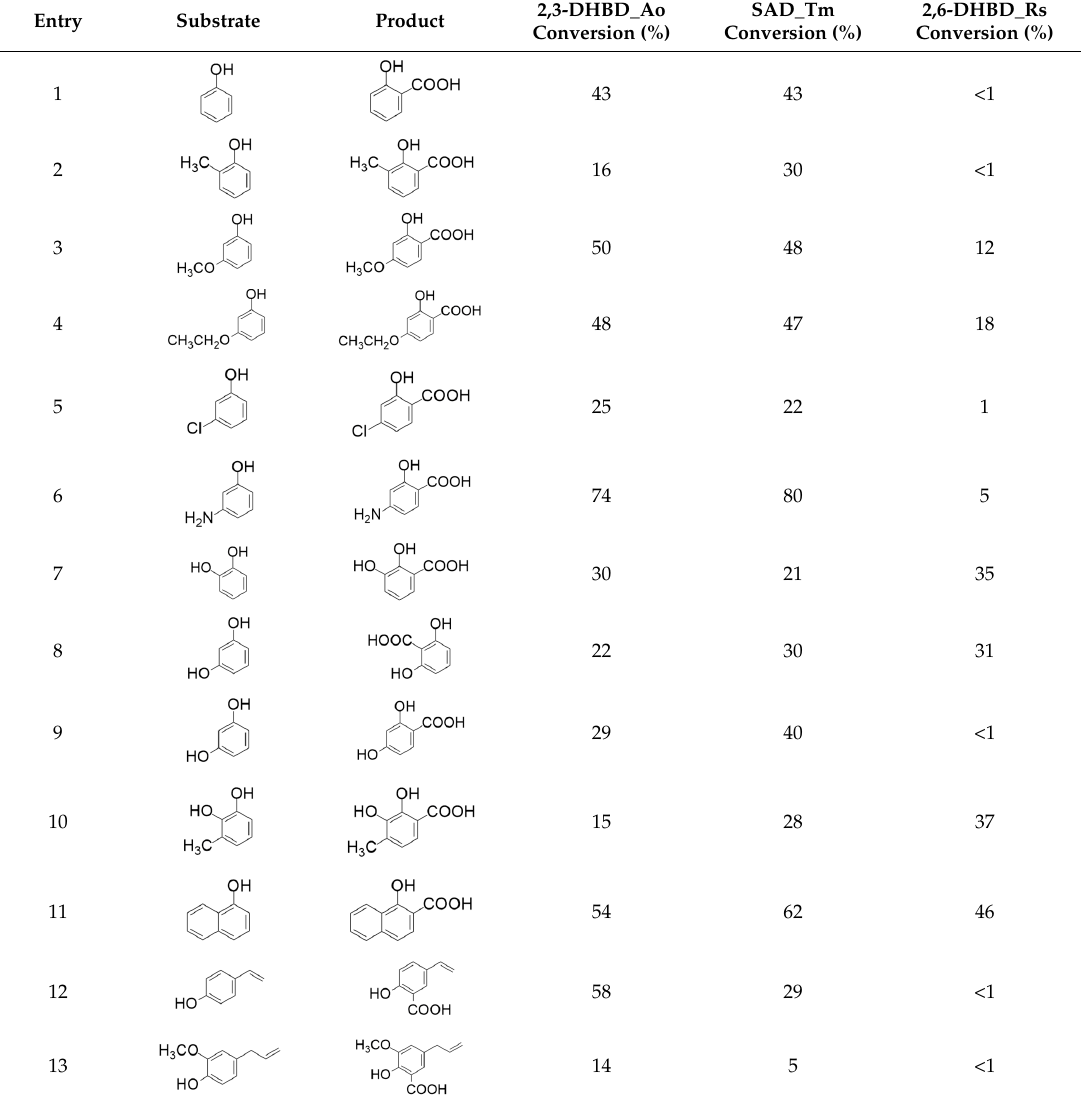
Table 3. Selective ortho -carboxylation of mono- and di-substituted phenols using HCO 3 − (selected examples from Ref. 45). Adapted with permission from [45]. Copyright 2014, Royal Society of Chemistry.